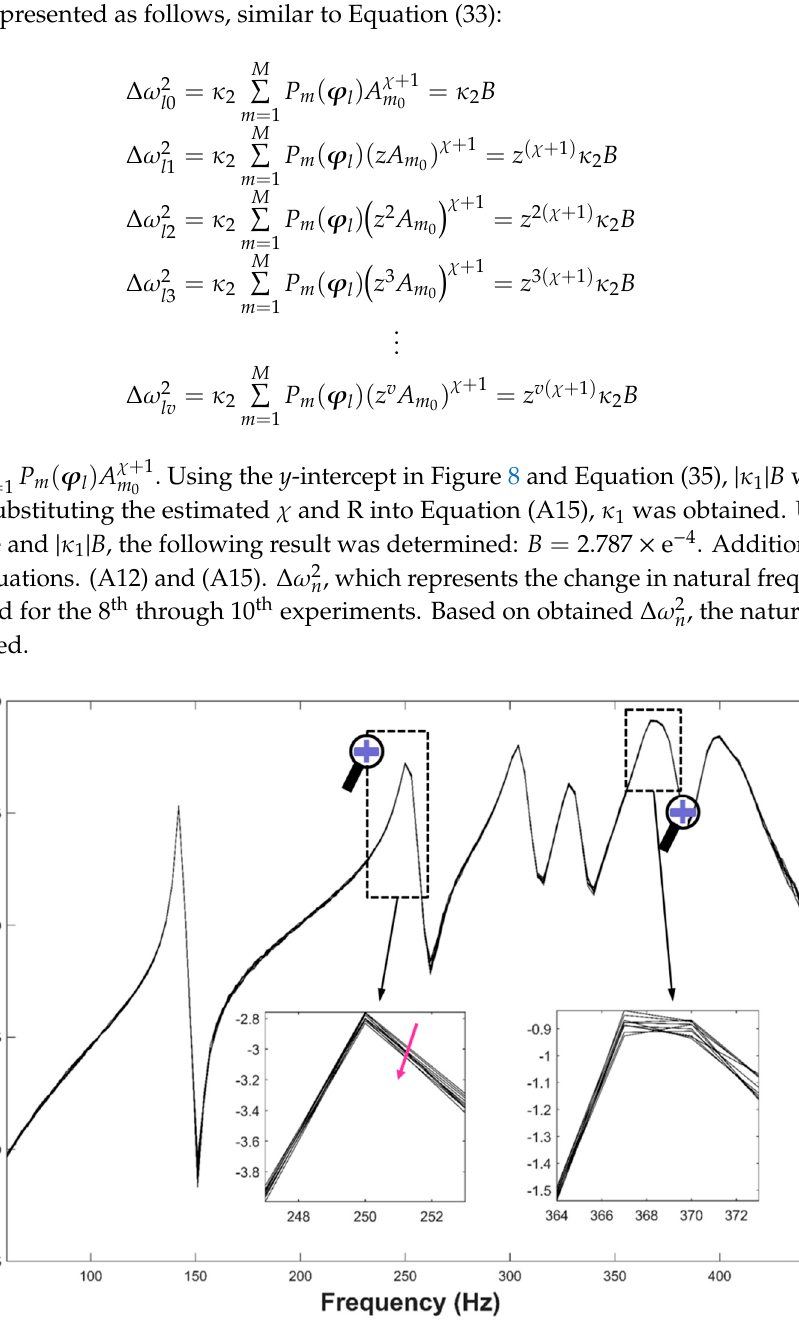
Figure 7. Measured frequency response functions.